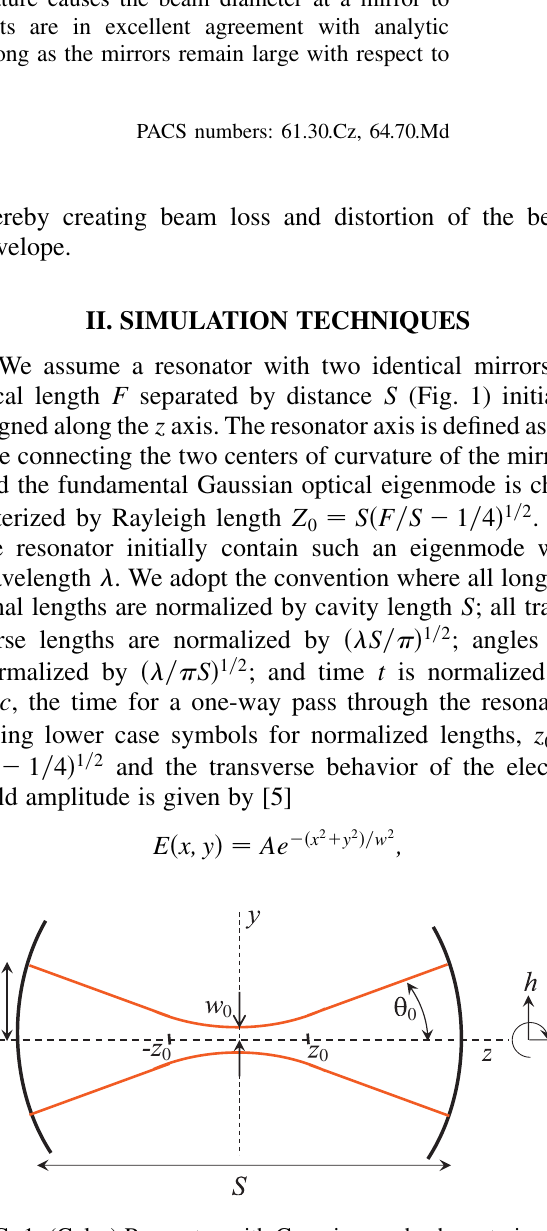
FIG. 1. (Color) Resonator with Gaussian mode characterized by . Vibrations of the right-hand mirror include Rayleigh length z 0 , transverse shift h , longitudinal shift (cid:1) S , and focal length tilt (cid:3) m change (cid:1) f (not shown).*Email address: